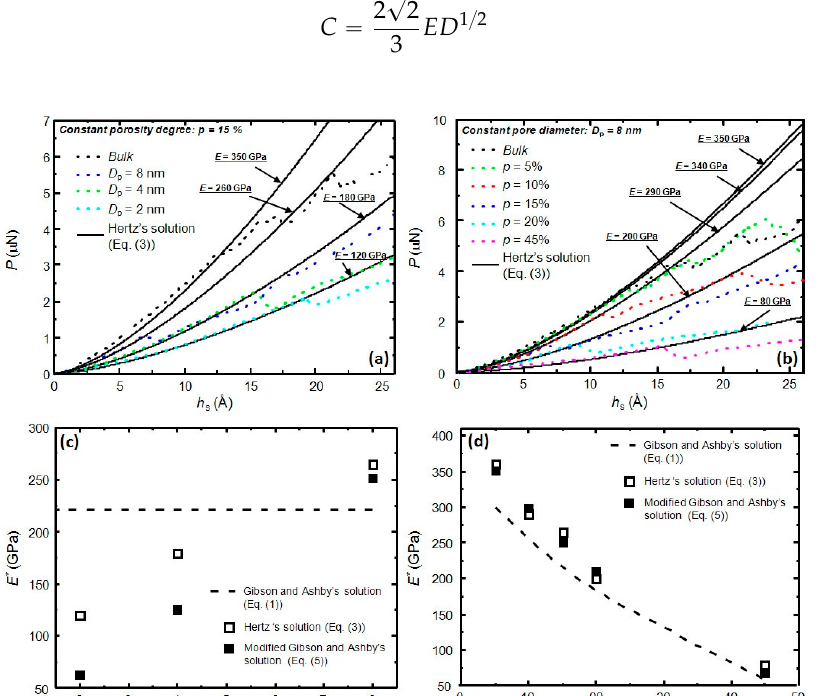
Figure 1. ( a ) Applied load ( P )—penetration depth ( h s ) curves for molecular dynamics (MD) simulations (dotted lines) of spherical indentation on (001) copper single crystals. Solid lines correspond to Hertz’s solution (Equation (3)) for spherical indentation, used to determine the elastic moduli (indicated in the plot) during the first stages of indentation for the different simulations. Except for the bulk case, all simulation boxes in ( a ) correspond to a constant porosity p = 15% and a variable pore diameter ( D p ), from 2 to 8 nm; ( b ) Same as in ( a ), but here, except for the bulk case, all simulation boxes correspond to a constant pore diameter D p = 8 nm and a variable porosity degree ( p ), ranging from 5% to 45%; ( c ) Dependence of Young’s modulus ( E *) on the pore diameter ( D p ) for a constant porosity P = 15%. The plot compares the elastic moduli extracted from MD simulations using Equation (3) (Figure 1a) with the predicted values obtained from Equation (1) and with the proposed modification of the Gibson and Ashby relation (Equation (5)); ( d ) Dependence of Young’s modulus ( E *) on the porosity degree ( p ) for a constant pore diameter ( D p = 8 nm). Again, the plot compares the elastic moduli extracted from MD simulations (Figure 1b) with the predicted values obtained from Equation (1) and with the proposed modification of the Gibson and Ashby equation (Equation (5)).